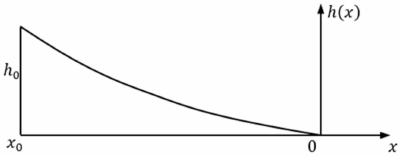
Figure 1. Plate with an ideal parabolically tapered